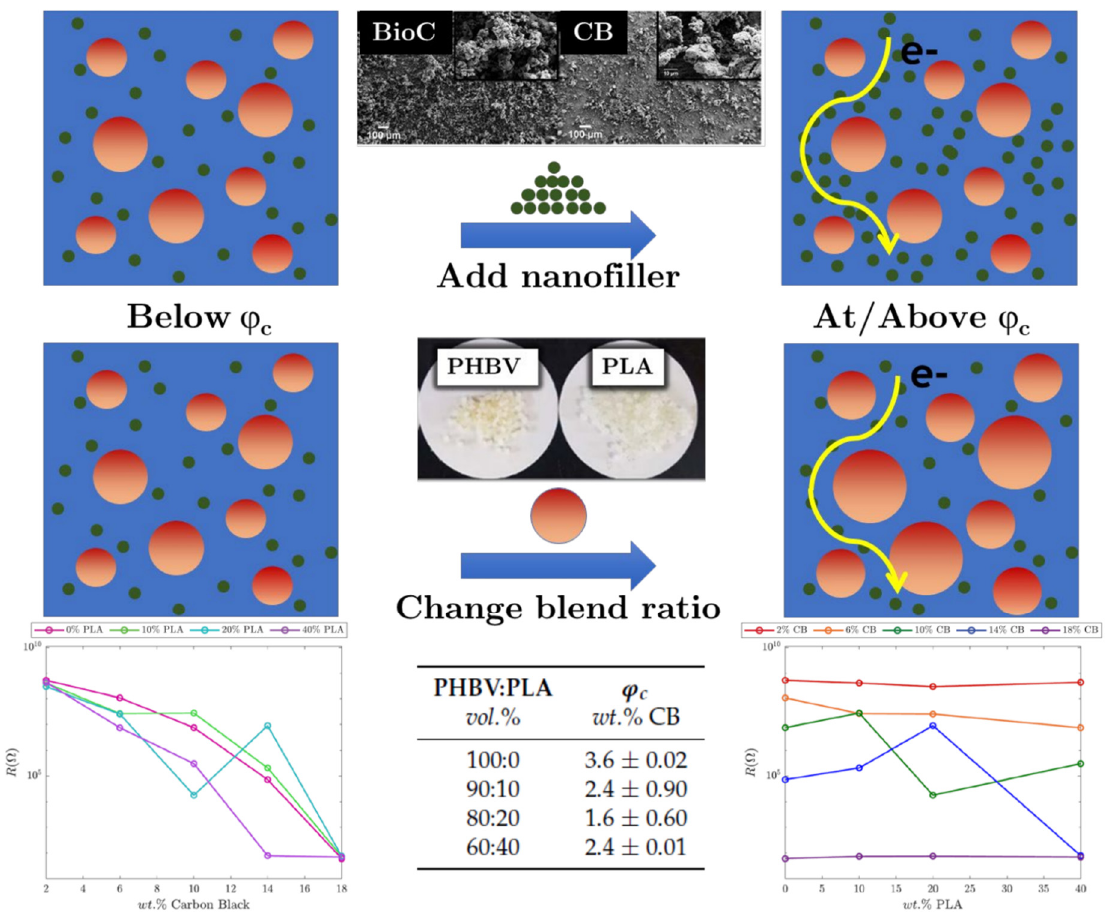
Figure 6. Incorporation of CNT into PHBV: PLA blends and their corresponding properties [24].